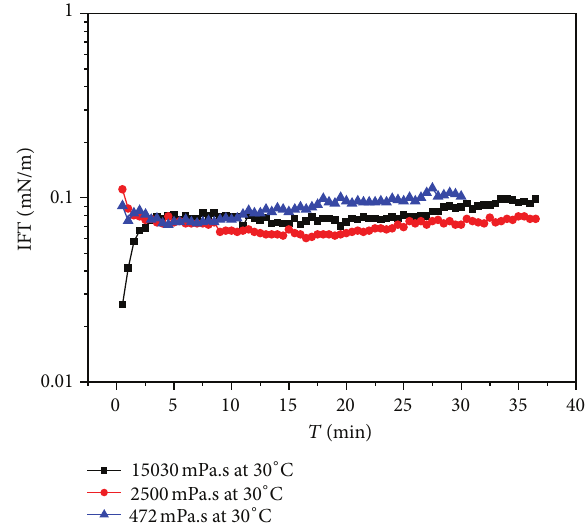
Figure 10: Pressure changes during alkaline flooding for Zhuangxi heavy oil (alkaline concentration = 0.5 wt%).